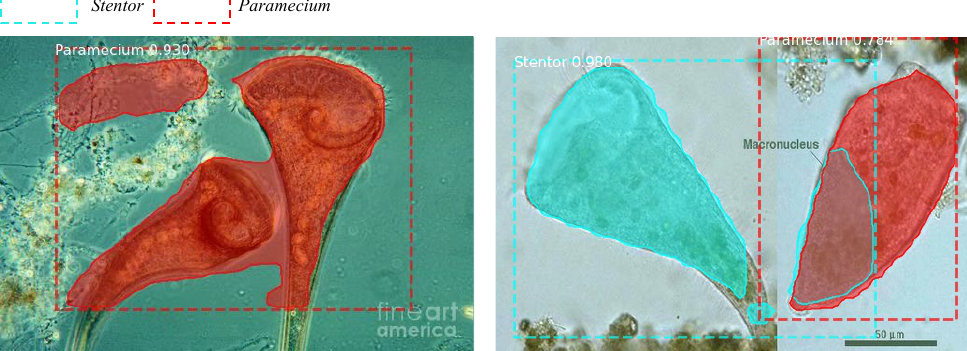
Figure 16. The example images of Stentor which are classified as Paramecium in EMDS-6.The color boxes indicate the positions predicted by SEM-RCNN, for which its captions indicate the predicted categories and the probabilities.